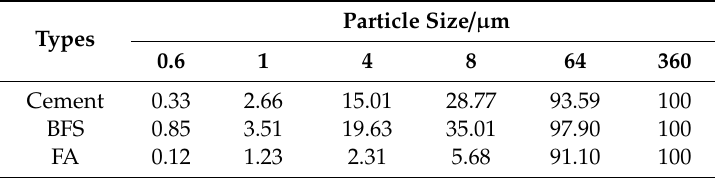
Table 1. Particle passing percentage of the cementitious materials.